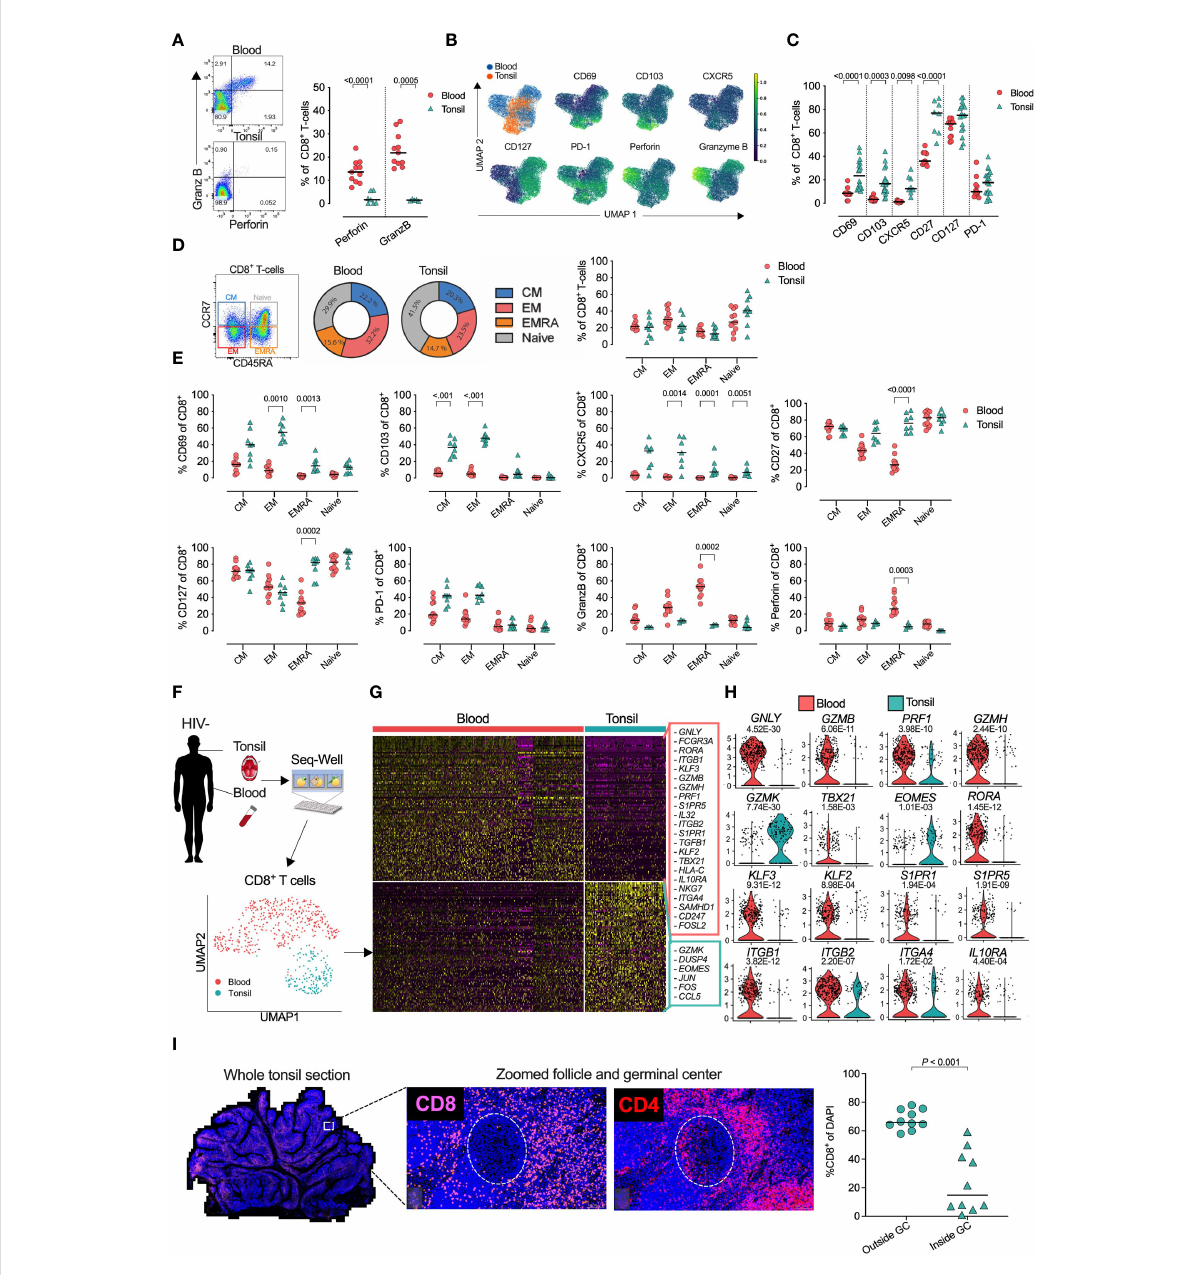
FIGURE 1 Tonsil CD8 + T-cell resident phenotype and transcriptional signature with distinct in situ location within whole tonsil section. (A) Blood ( n= 11) and tonsil ( n= 18) mononuclear cells pre-gated on CD8 + T-cells by fl ow cytometry for perforin and granzyme B (GZMB). (B) Expression intensity of CD69, CD103, CXCR5, CD127, PD-1, Perforin and GZMB in multidimensional UMAP space for CD8 + T-cells, gated from total live CD45 + CD3 + T-cells. Peripheral blood (blue), tonsil tissue (orange). (C) Percentage of blood ( n= 11) and tonsil ( n= 7) bulk CD8 + T-cells expressing indicated markers. (D) Memory phenotype by CD45RA/CCR7 expression in blood and tonsil CD8+ T-cells. (E) Indicated markers compared in four CD45RA/CCR7 memory populations. (F) Schematic of protocol for scRNAseq of CD8 + T-cells from peripheral blood ( n= 3) and tonsil ( n= 2) tissue by Seq-Well S 3 with UMAP of 496 CD8 + T-cells coloured by tissue source (bottom). (G) Heatmap of z-scored gene expression of CD8 + T-cells illustrating 440 differentially expressed genes between blood and tonsil with selected genes highlighted (right). (H) Violin plots showing selected genes for cytolytic, transcription factors, tissue-resident memory and immune suppressive markers, expressed in CD8 + T-cells. FDR- adjusted p<0.05; full results can be found in Supplementary Table S1. (I) Fluorescence immunohistochemistry of whole tonsil section (left) from HIV uninfected donor shown by CD8 and CD4 panels in white box zoomed area (middle) with quanti fi cation using 10 unrelated areas identi fi ed outside follicles (outside GCs) and within follicular germinal centers (inside GCs) as de fi ned by PD-1 expression. P-values by Kruskal-Wallis corrected for multiple